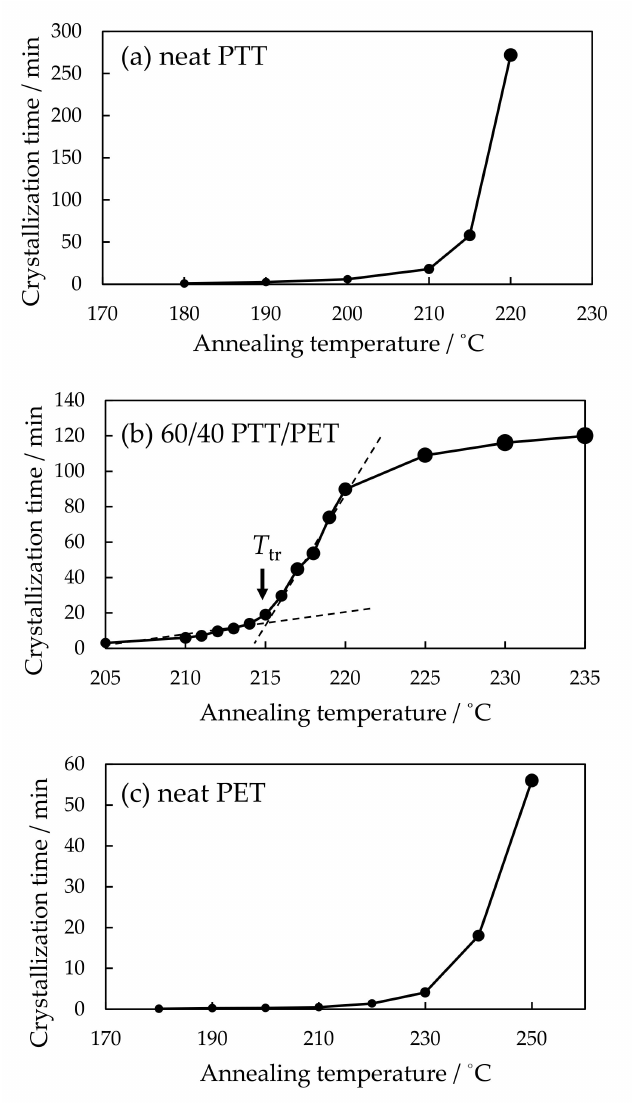
Figure 5. Crystallization time of ( a ) neat PTT, ( b ) 60 / 40 PTT / PET and ( c ) neat PET at various annealing